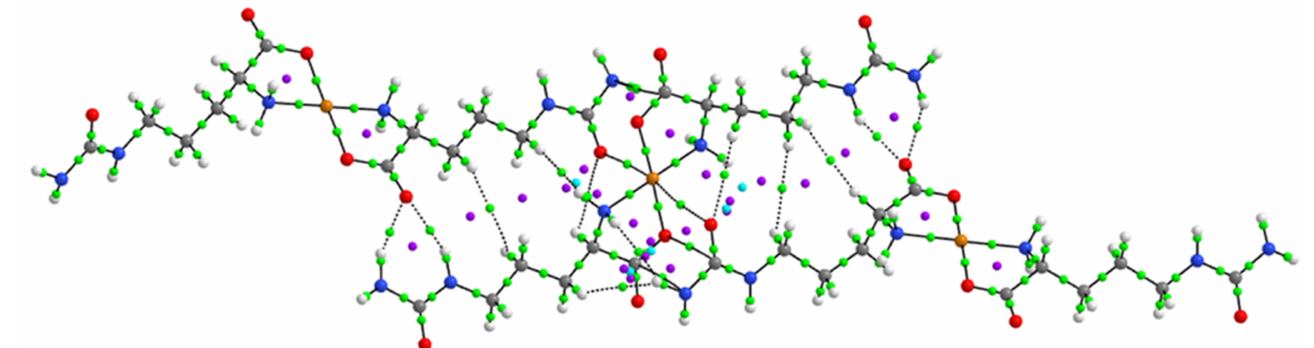
Figure 11. Molecular graphs of compound [Cu(Citr) 2 ] n showing the main BCPs of the H-bonds and RCPs between citrulline